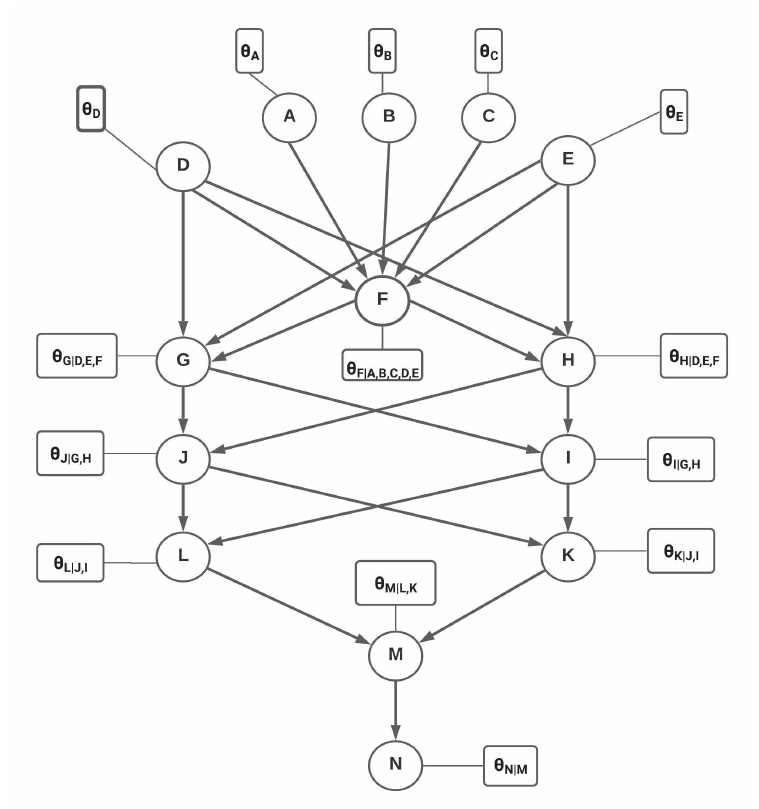
Figure 3. Directed acyclic graph (DAG) of the lysine biosynthesis pathway. Each node (circle) represents a gene in the pathway. The rectangular boxes represent the local probability distributions of the respective nodes. Each node is modeled as a categorical random variable with the following states: active (1), dormant (0), and inhibited ( −